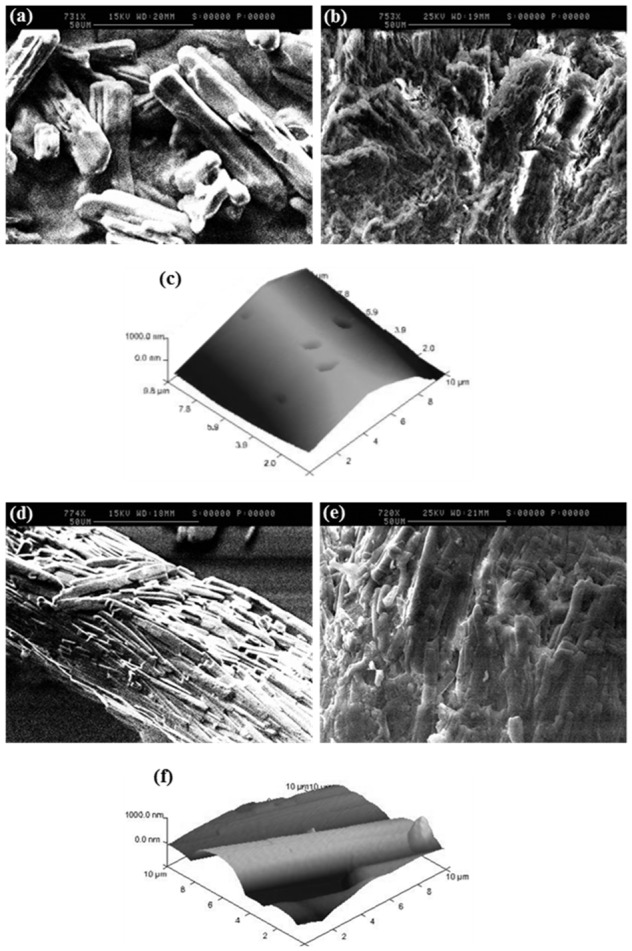
Micro and nano structural features of ibuprofen and theophylline from SEM and AFM.(a) & (b) are SEM images for ibuprofen powder (smooth) and tablet (surface fragmentation while particles still retain their elongated shape) respectively, (c) AFM image showing ibuprofen particle smooth surface although few dips can also be seen which might occurred due to surface fragmentation of the drug, (d) & (e) show SEM images for theophylline particle and theophylline tablet respectively (drug crystallites are compacted on each other in theophylline), (f) AFM topographical image showing theophylline surface crystallites. The crystallite in the middle of the image is cylindrical and has a smooth surface.